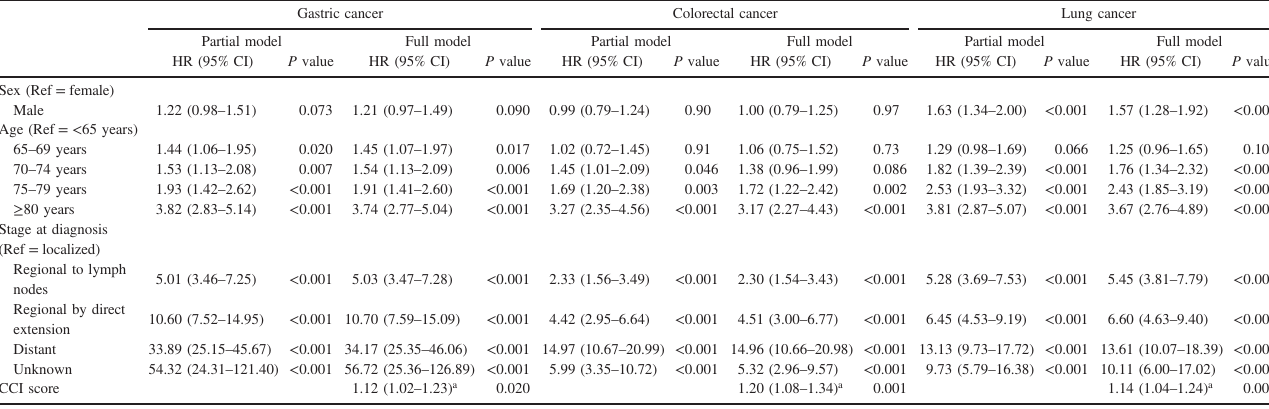
Table 3. Adjusted hazard ratios of all-cause mortality derived from Cox proportional hazards models according to cancer type